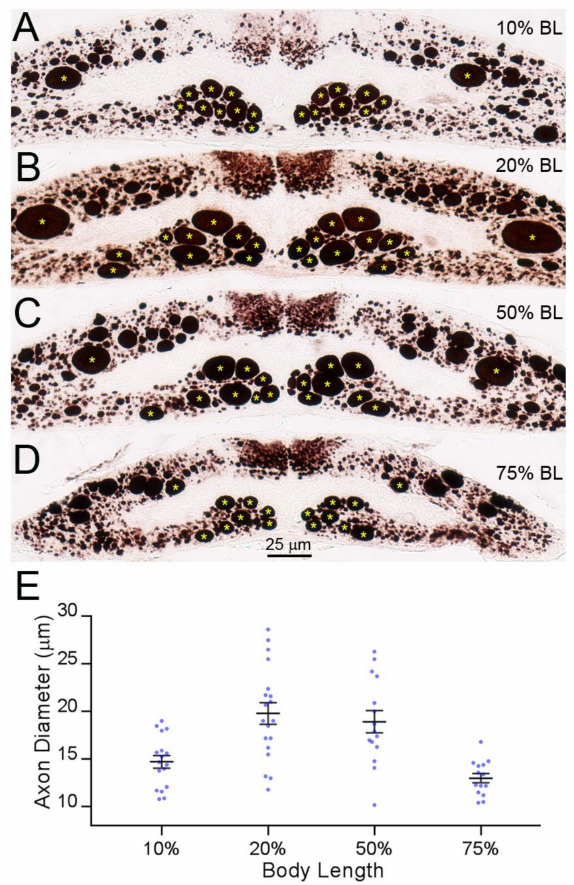
Figure 7. RS axon calibers vary along their course in the lamprey body. ( A – D ) Transverse sections along the length of the spinal cord stained with an anti-neurofilament (NF) antibody. The largest axons in the ventro-medial white matter belong to identified RS neurons (Müller cells), and the large axons in the dorsolateral column belong to the Mth neurons; ( E ) diameters of the large RS axons (*) along the body length (means ± SEM). Axon diameters at the 10% and 75% BL are